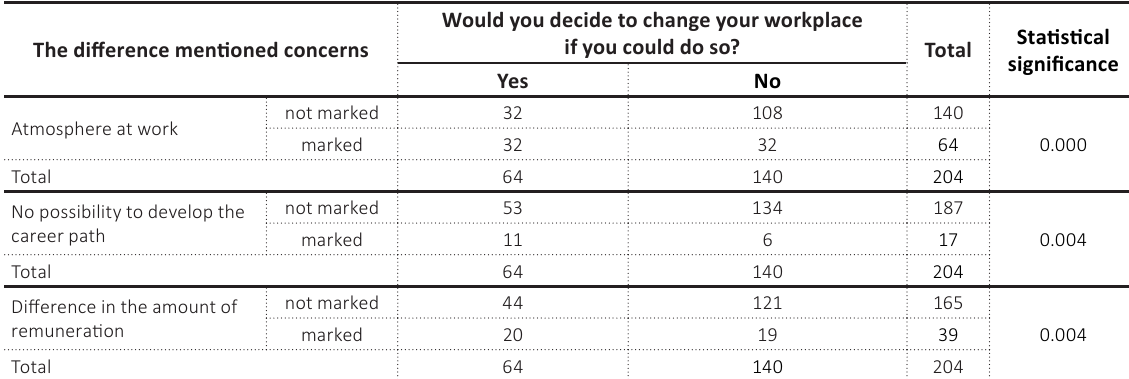
Table 5. Analysis of answers to questions 5 and 10 of the